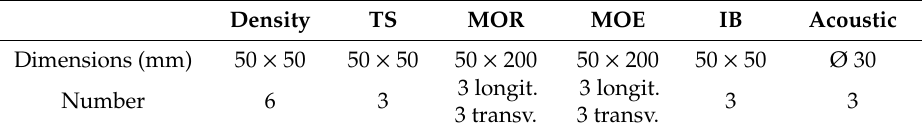
Table 3. Dimensions and number of samples of each board used in the tests.